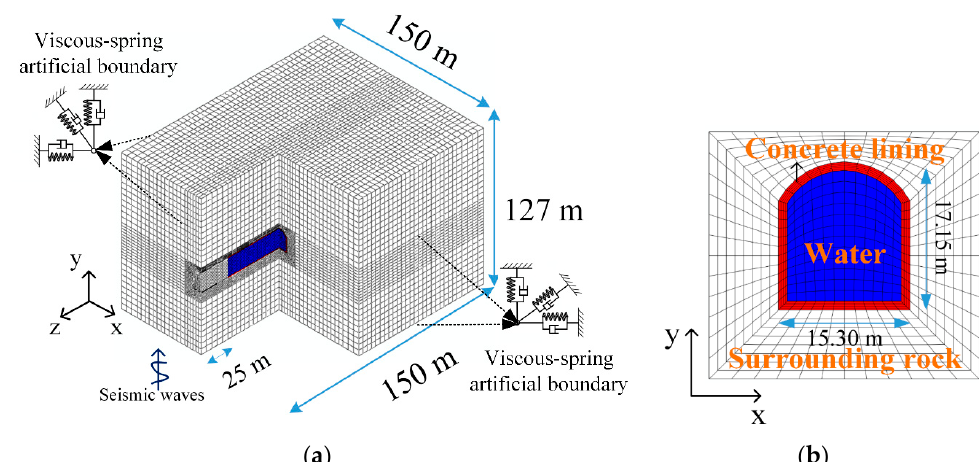
Figure 4. 3D FE model of a hydraulic arched tunnel [36]. (( a ) FE model, ( b ) enlarged plot of the local refinement diagram).